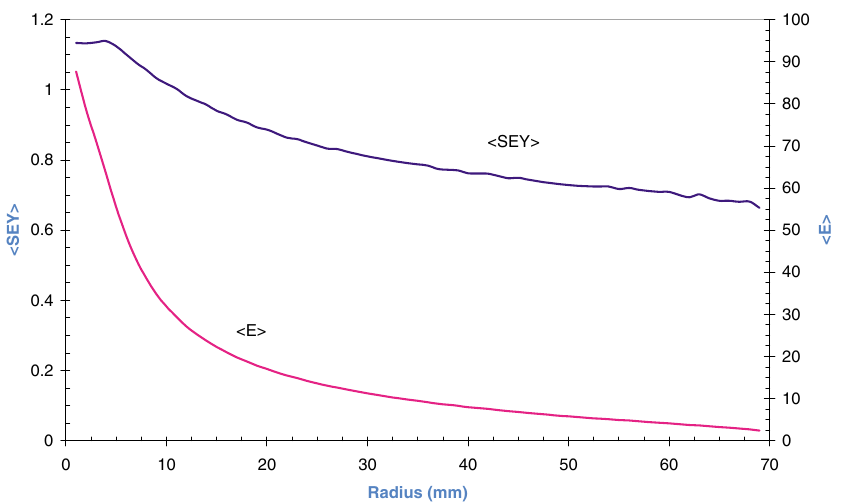
FIG. 6. (Color) Average h SEY i and average electron energy versus the radial position perpendicular to the field lines.